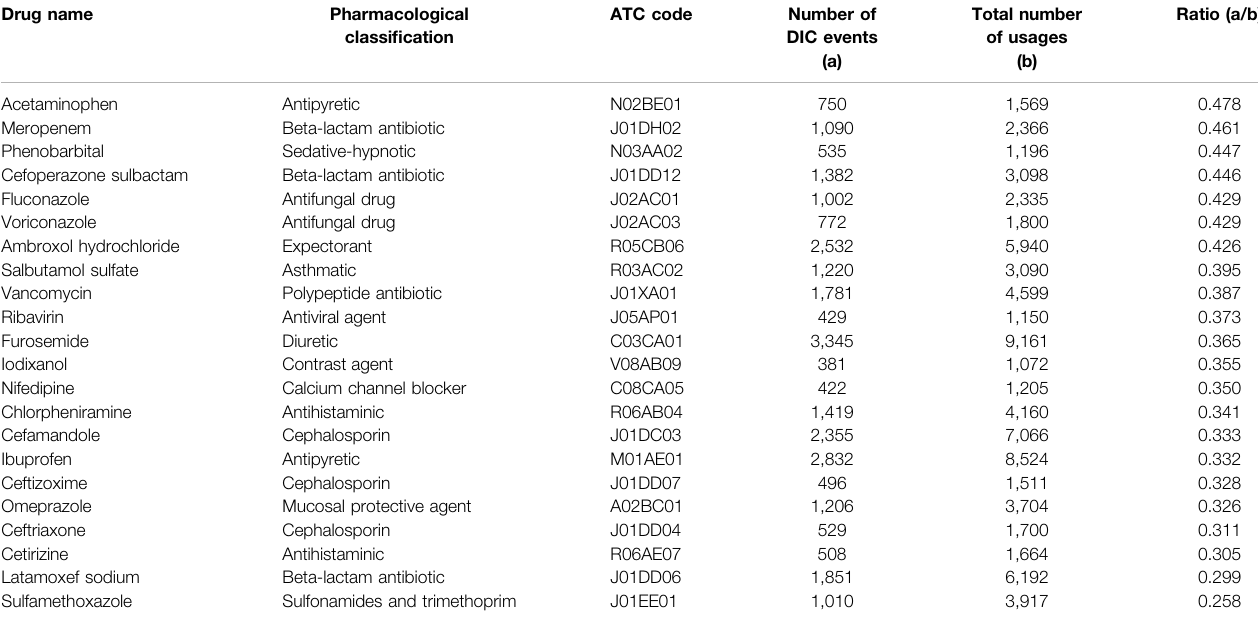
TABLE 1 | Suspected drugs associated with coagulopathy in the pediatric